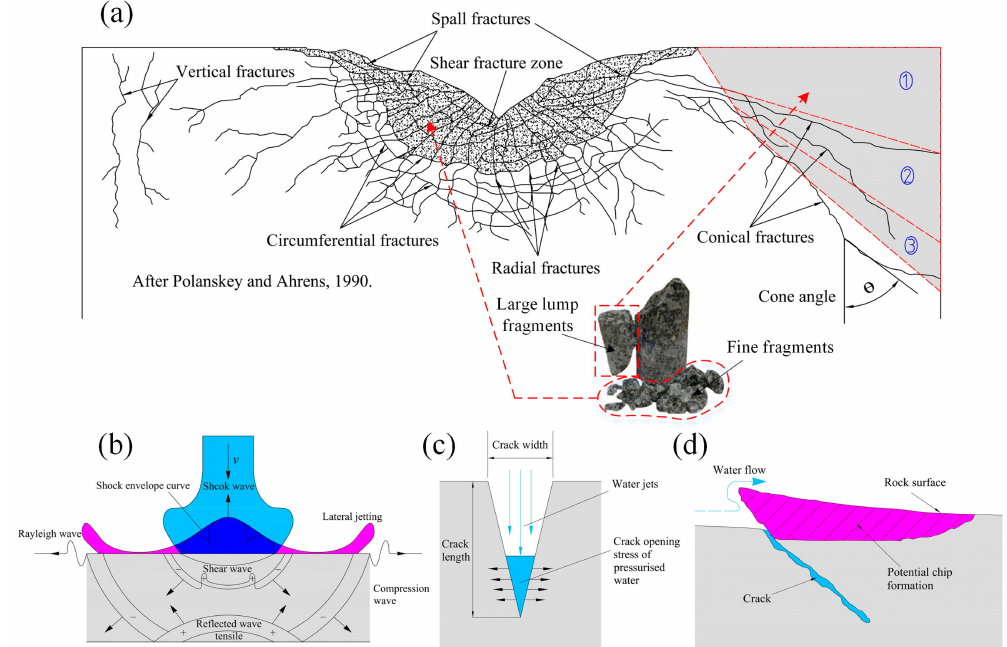
Figure 14. ( a ) Different failure patterns observed inside the rock samples and the failure mechanisms of rock under water jet impact: ( b ) shock stress wave effect, ( c ) pressured water wedge effect, and ( d ) water flow scouring effect